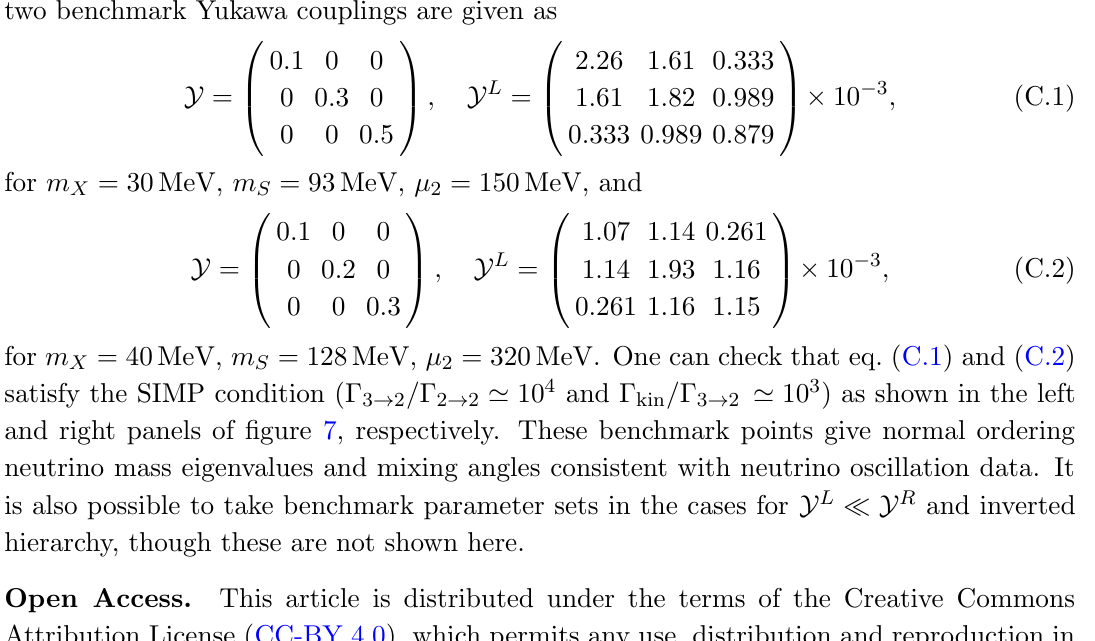
for m = 30 MeV, m X